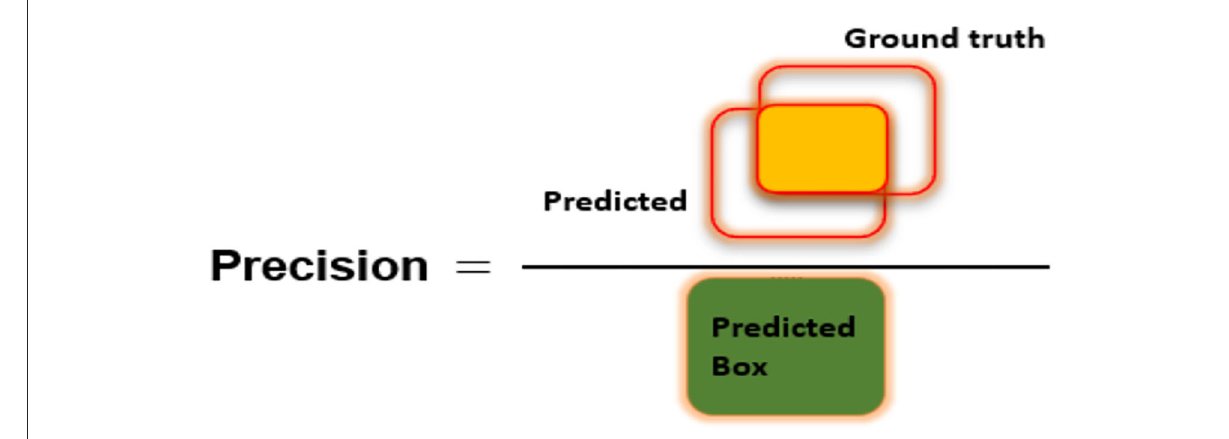
FIGURE7 Visual demonstration of Precision metric.